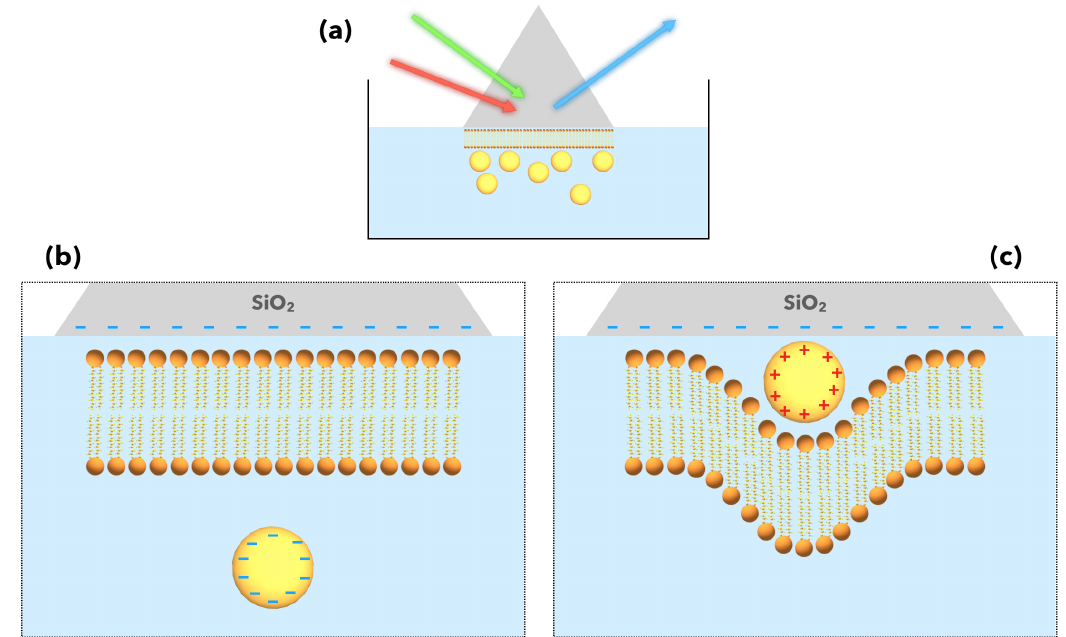
Figure 9. ( a ) Applications of SFG spectroscopy to the study of the interactions of AuNPs with biological material in aqueous medium. ( b ) Effect of a total negative surface charge (SiO 2 and AuNPs) on the nanoparticle interaction with a model membrane (lipid bilayer) where no penetration is observed. ( c ) same as ( b ) but for positively charged AuNP surface. This time, the AuNPs crosses and distorts the lipid bilayer to reach the SiO 2 surface. Figure panel is reprinted (adapted) with permission from [74], copyright 2016 American Chemical